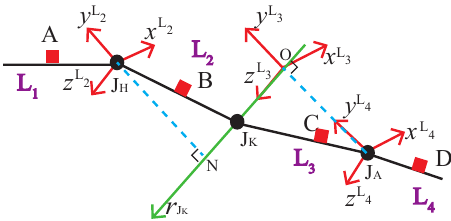
Figure 4. Structural diagram of human lower